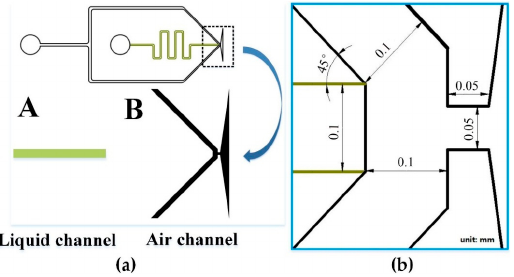
Figure 1. Photo mask and nozzle size of the ESFFI microfluidic chip. ( a ) Photo mask of the ESFFI microfluidic chip. ( b ) Nozzle size of the ESFFI microfluidic chip.